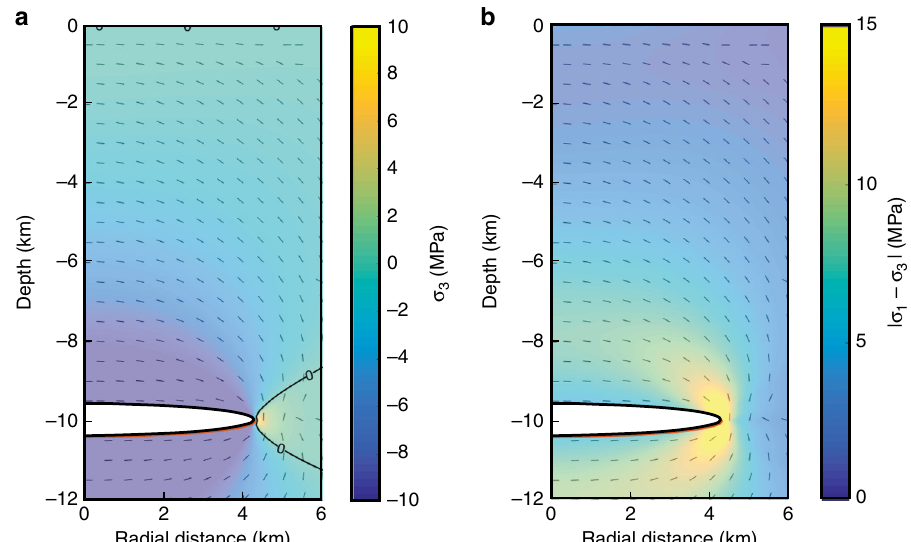
Fig. 8 Stress fi elds related to major drainage of magma. a Amplitude of the minimum compressive stress, shown by the colour scale with negative values for tension, induced by combined buoyancy and under-pressure due to magma out fl ow ( Δ ρ gh + Δ P magma body, fl ow ) equal to − 13.3 MPa, corresponding to the model presented for Bárðarbunga. Direction of maximum compressive stress ( σ 1 ) is represented by dashes. Most of the medium is put under tension with maximum effect immediately above the magma body. b Shear stress (amplitude of σ 1 – σ 3 ; shown by the colour scale) for the same conditions as in a . The panels show that the stress fi eld is favourable for caldera collapse initiation induced by the